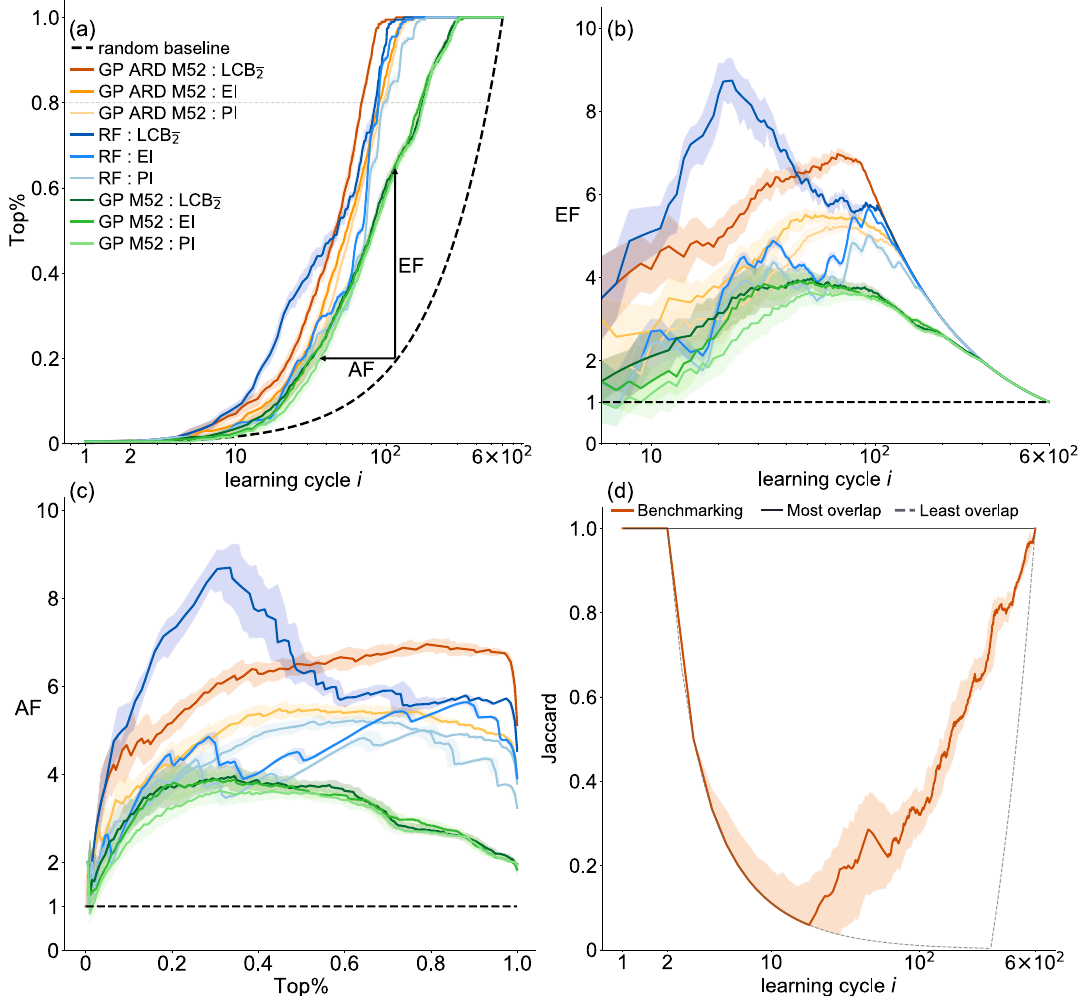
Fig. 3 The aggregated performance of BO algorithms on the Crossed barrel dataset. Performance is measured by a Top% vs. learning cycle i against a random baseline, b Enhancement factor EF and c Acceleration factor AF, respectively. The algorithms with GP ARD as a surrogate model are labeled in red, RF in blue, and GP in green; higher color saturation is correlated with better performance. Variation at each learning cycle is visualized by plotting the median as well as shaded regions representing the 5 th to 95 th percentile of the aggregated 50-run ensembles. The acquisition functions used are EI, PI, and LCB λ d Jaccard similarity index calculated between the optimization campaign sequences of BO algorithms RF: LCB and GP ARD: LCB . The median, 5 th , 95 th percentile of the 50-run ensemble are shown 2 2